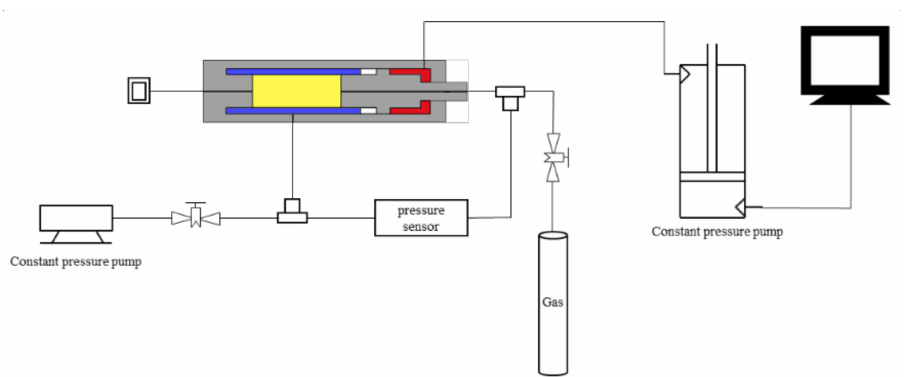
Figure 5. Flowchart of the experimental design of crack creation.